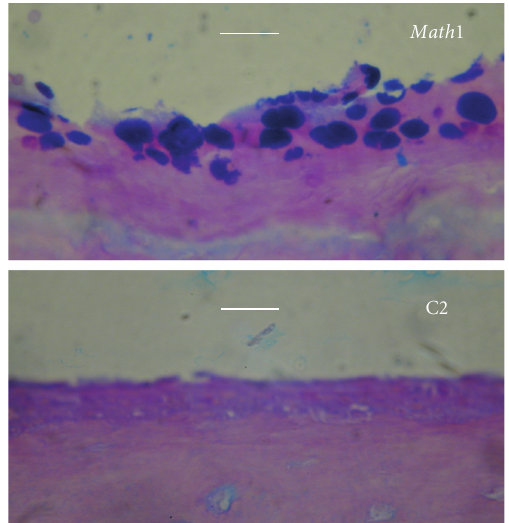
Figure 3: Math1 transfection increases the mucous cells in the middle ear mucosa of mice. Full-length Math1 cDNA was cloned into a protein-expressing vector (C2, pEGFP, Clontech). To study the role of Math1 in the middle ear mucosa, bilateral bullae of 5 mice were transfected with 10 μ L of Math1 and empty vectors, respectively, at 1.4 μ g/mL in Opti-MEM containing Lipofectin at 6 μ g/mL via the tympanic membrane approach. Transfected animals were sacrified 7 days after Math1 transfection for harvest of the bullae. Math1 transfection had more AB-PAS positive cells in the mouse middle ear mucosa (upper) than empty vector (C2) transfection (lower). Bar = 10 μ